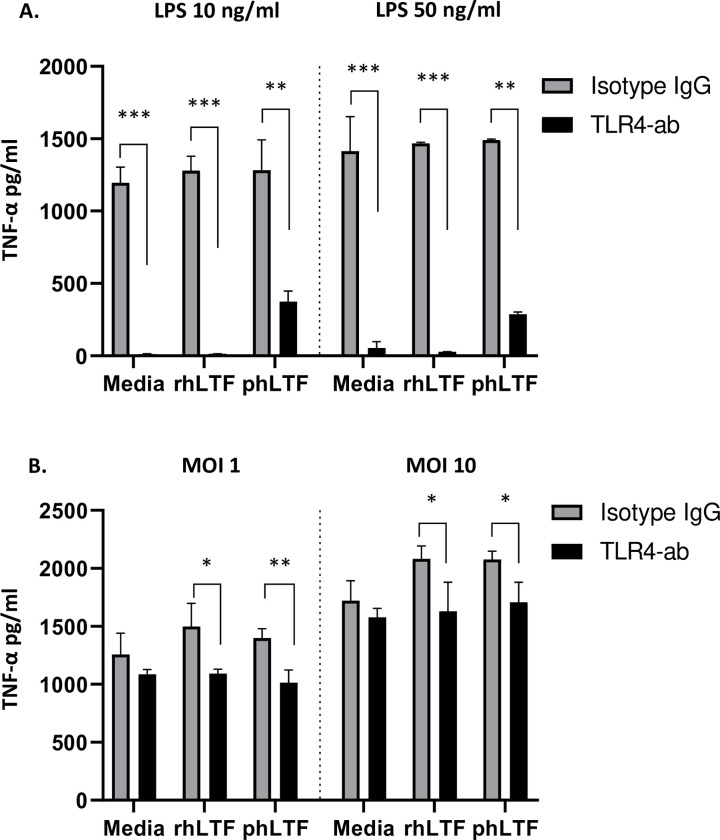
Lactoferrin-induced TNF-α production following Bt infection of differentiated THP-1 cells is attenuated by blockade of TLR4.Differentiated THP-1 cells were exposed to E. coli K12 LPS at 10 ng/ml or 50 ng/ml (A) or infected with Bt at an MOI of 1 and 10 (B). At one hour, cells were treated with media or with 100 μg/ml of either rhLTF or phLTF and concurrently with either 20 μg/ml of TLR4-ab or IgG isotype control. After six hours, cell supernatants were collected and TNF-α was measured by ELISA. Means ± standard deviations of duplicate or triplicate conditions are displayed. TLR4-ab vs isotype groups were compared for each condition by t-test (* p<0.05; ** p<0.01; ***p<0.001). The concentration of cytokines in uninfected cells, for all conditions, was below the level of detection. One representative example of two independent experiments is shown.